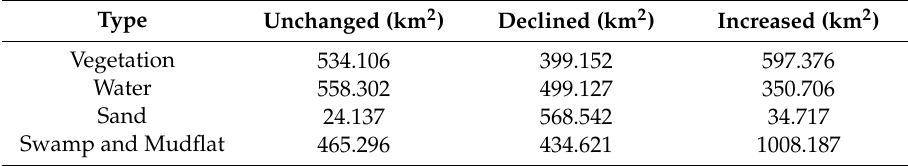
Table 4. The areas of di ff erent wetland type changes in Poyang Lake from